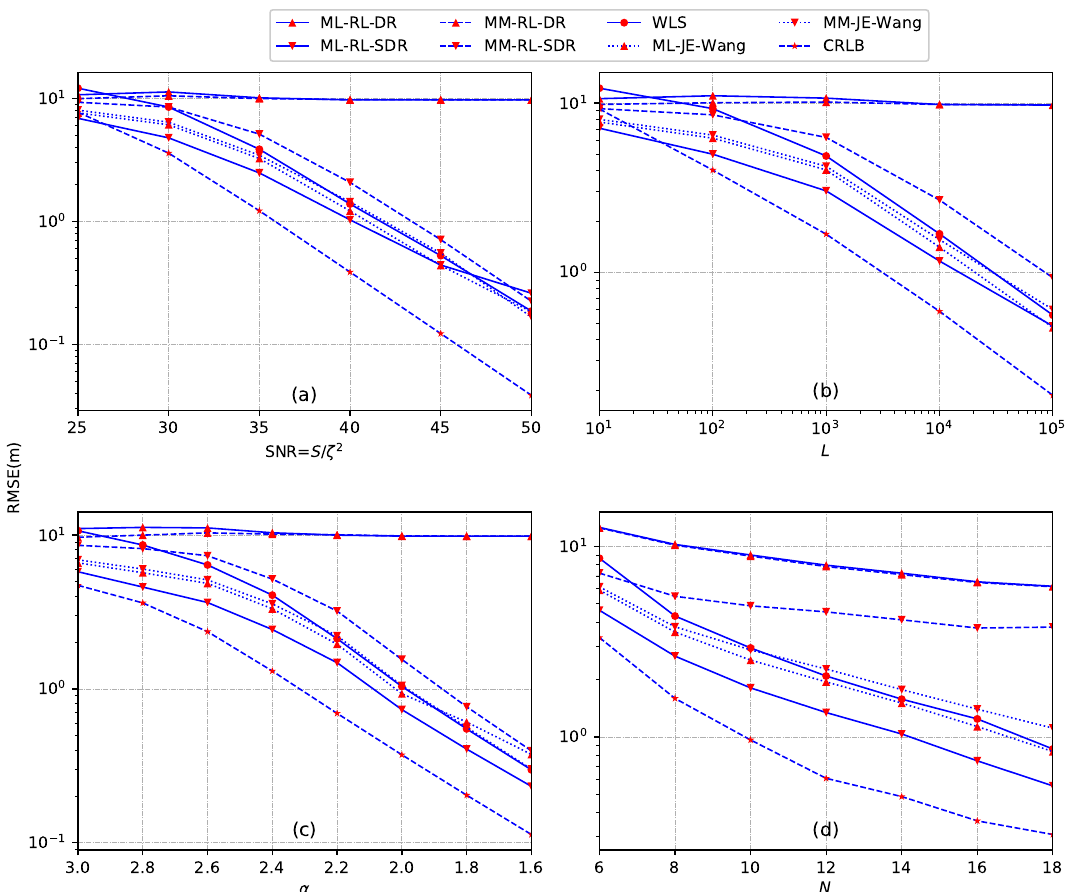
Figure 11. Performance analysis when the source is located randomly in a region of size 50 × 50 m 2 . ( a ) RMSE versus SNR; ( b ) RMSE versus L ; ( c ) RMSE versus α ; ( d ) RMSE versus N .